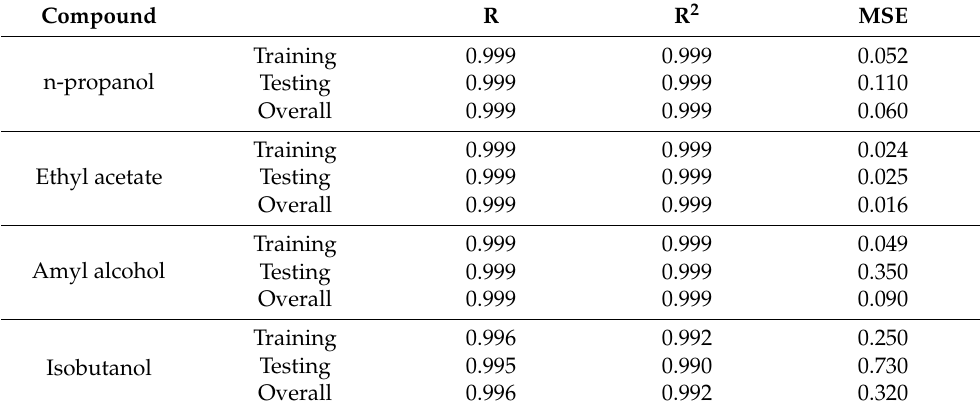
Table 4. Statistical data for ANNs